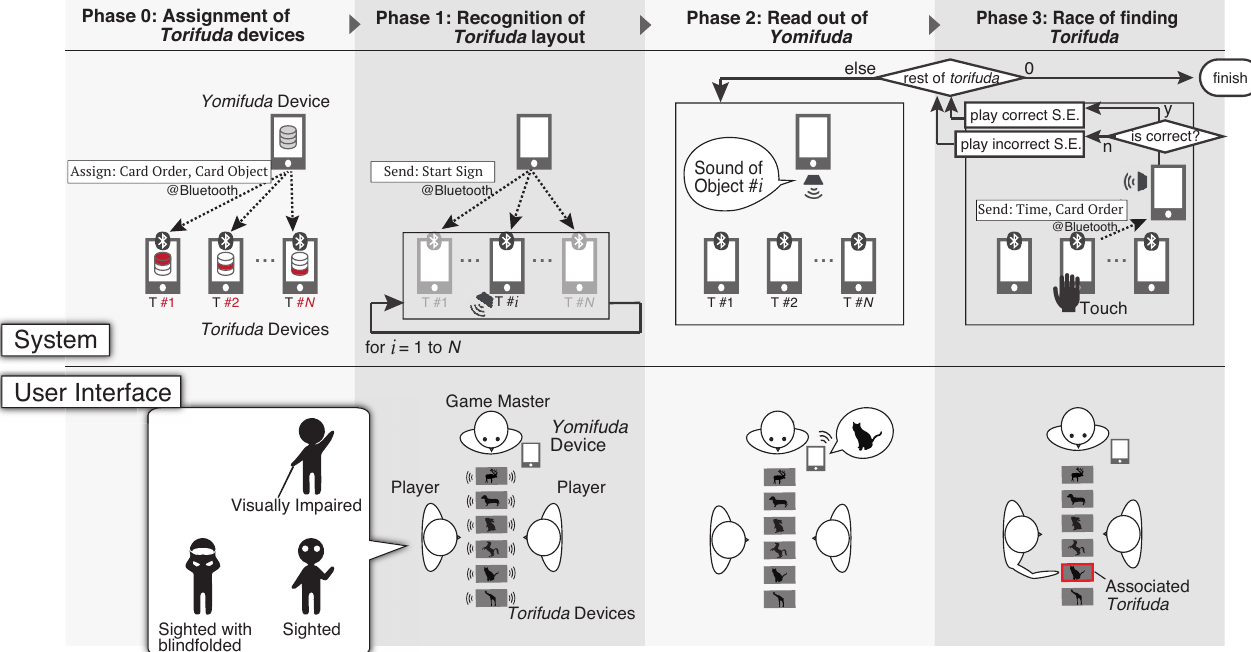
Figure 3. The behavior of the auditory card game system when playing “Auditory Uta-Karuta ” and the procedure of the game. All devices are communicated by signal. A game master operates the Yomifuda device to proceed the game.The players obtain the card by touching/grabbing the Torifuda device corresponding to the sound presented by the Yomifuda